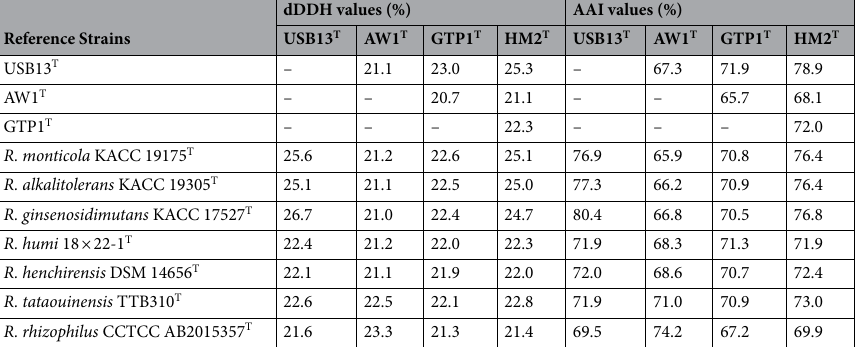
dDDH values (%) AAI values (%)